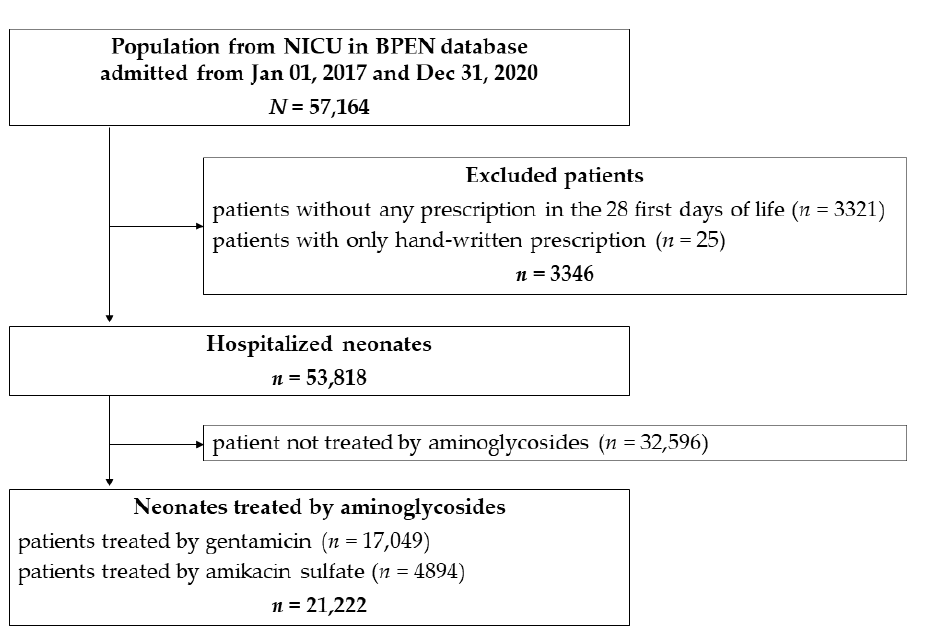
Figure 1. Selection of aminoglycosides treated population.